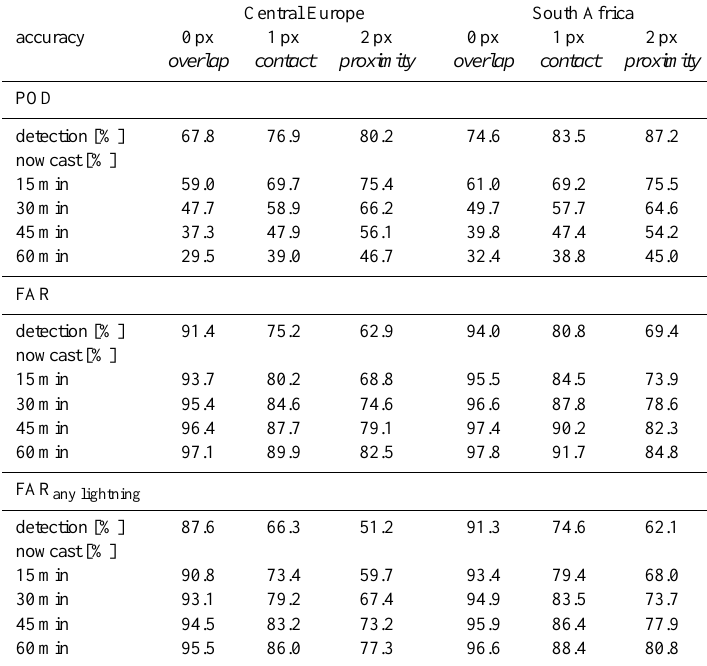
Table A3. Full day: pixel-based validation scores for the current Cb-TRAM detection scheme (day and night) for mature storms, and the 15, 30, 45 and 60min forecasts. Top – POD for intense lightning pixels ( > 10flashespixel − 1 15min − 1 ); centre – FAR with regard to intense lightning pixels ; bottom – FAR any lightning with regard to pixels containing any lightning ( > 0flashespixel − 1 15min − 1 ).